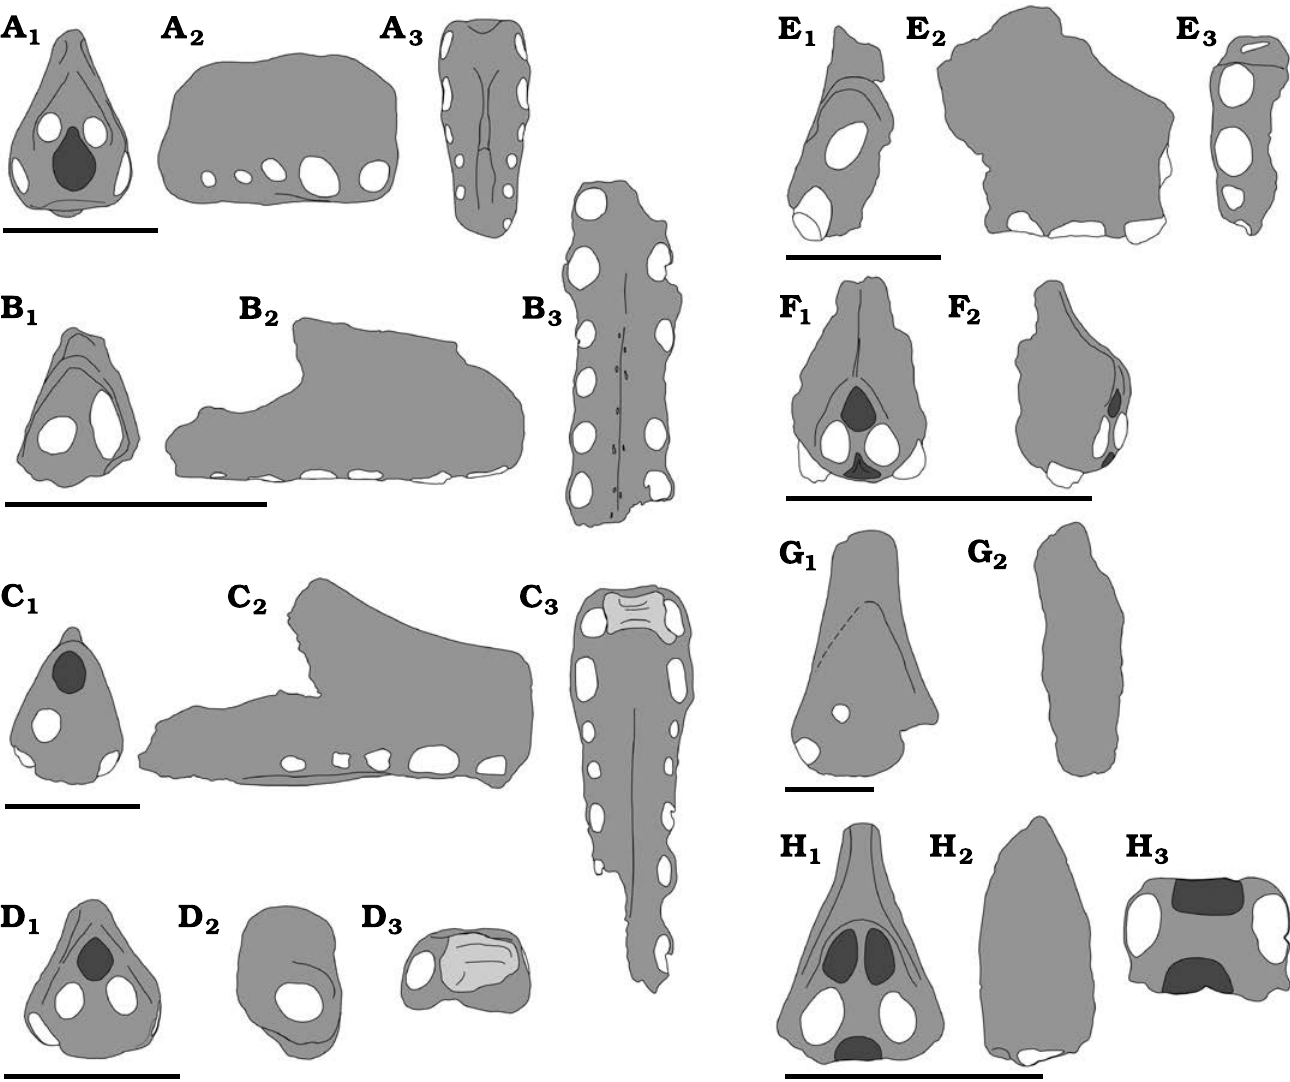
Fig. 11. Coloborhynchinae comparative plate. A . Coloborhynchus clavirostris in anterior (A 1 ), right lateral (A 2 ), and palatal (A 3 ) views. B . Aerodraco sedgwickii in anterior (B 1 ), right lateral (B 2 ), and palatal (B 3 ) views. C . Uktenadactylus wadleighi in anterior (C 1 ), right lateral (C 2 ), and palatal (C 3 ) views. D . Uktenadactylus rodriguesae . in anterior (D 1 ), left lateral (mirrored, D 2 ), and palatal (D 3 ) views. E . Nicorhynchus capito (holotype) in anterior (E 1 ), right lateral (E 2 ), and palatal (E 3 ) views. F . Nicorhynchus capito (referred specimen, originally designated as the holotype of Ornithocheirus reedi , now pre­ sumed lost from CAMSM collections) in anterior (F 1 ) and right lateral (F 2 ) views. G . Nicorhynchus cf. capito in anterior (G 1 ) and left lateral (mirrored, G 2 ). H . Nicorhynchus fluviferox (holotype) in anterior (H 1 ), right lateral (H 2 ), and palatal (H 3 ) views. Dark grey represents depressions, lighter gray with lines represents bulbous projections, white represents alveoli. Scale bars 50 mm. Drawings by